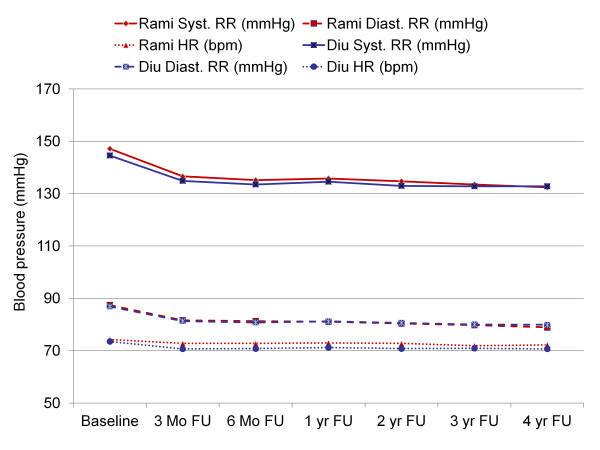
Office blood pressure throughout the 4 year follow-up. Legend: FU, follow-up; yr, year; RR, blood pressure (Riva Rocchi); HR, heart rate; Diu, diuretic based therapy; Rami, ramipril based therapy.